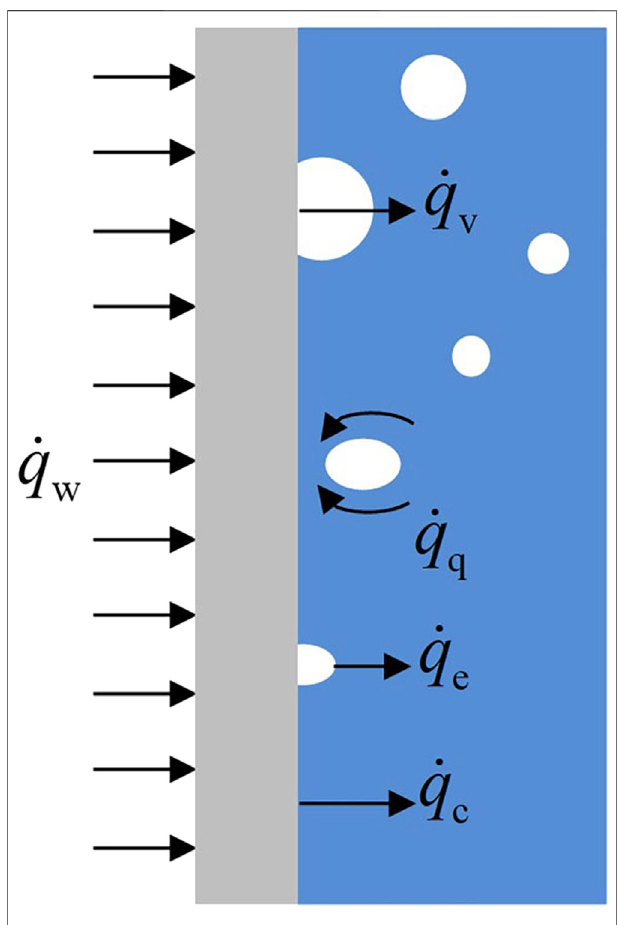
FIGURE 1 | Schematic of wall boiling heat fl ux